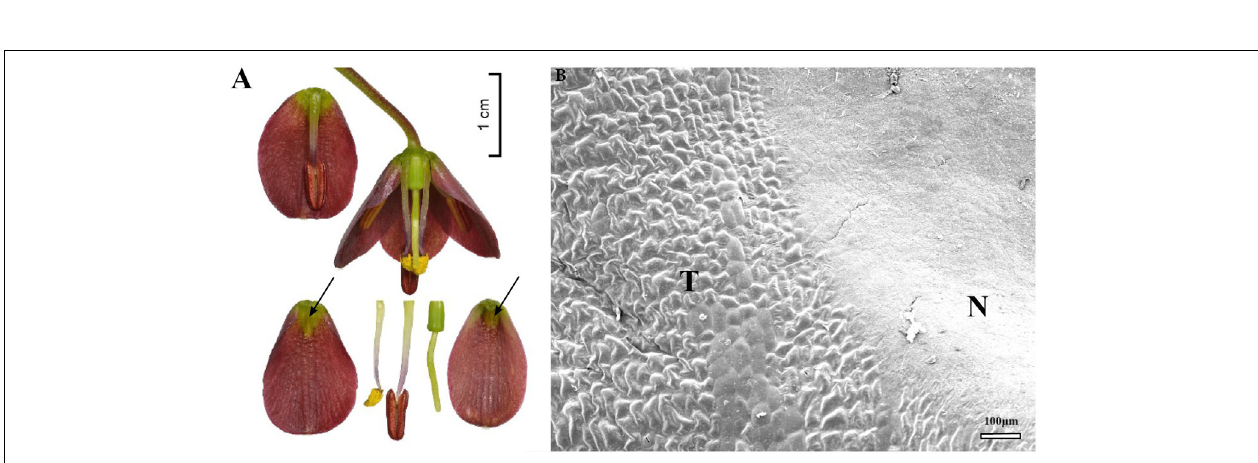
Frontiers in Plant Science |